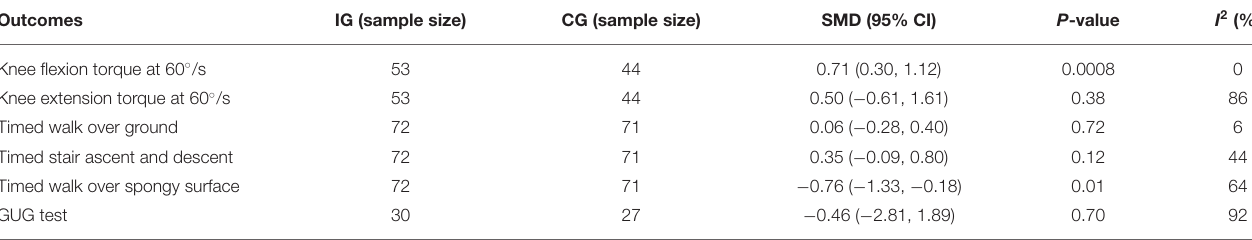
TABLE 4 | Meta-analysis results of muscle strength and mobility when proprioceptive training compared to other non-proprioceptive training.